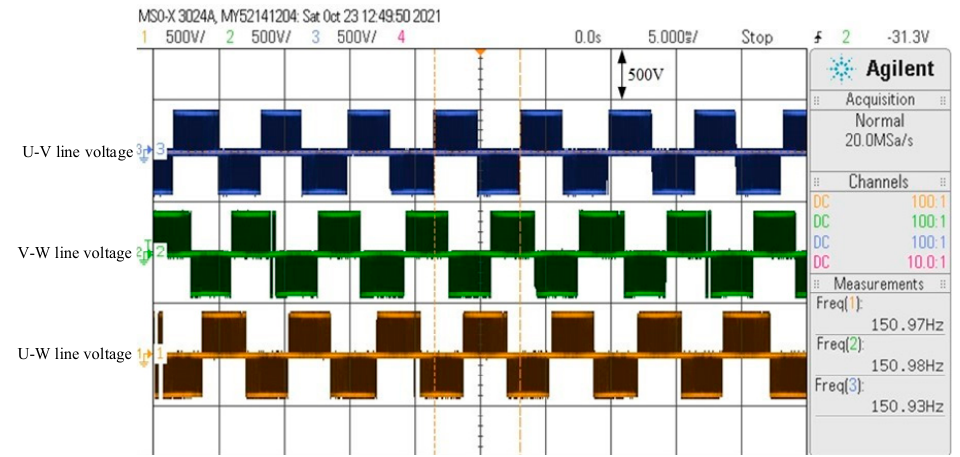
Figure 24. Output line voltage waveform of the drive developed at rotational speed frequency command of 150 Hz.